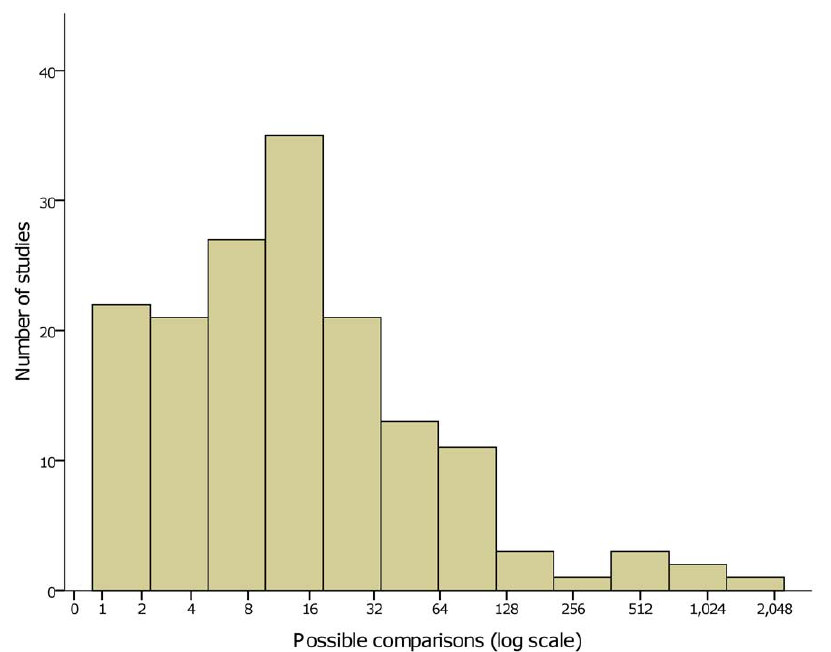
Figure 7. The theoretical number of total comparisons in 161 full-text articles. Calculated by multiplying the number of gene alleles studied by the number of drugs investigated by the number of outcomes recorded.